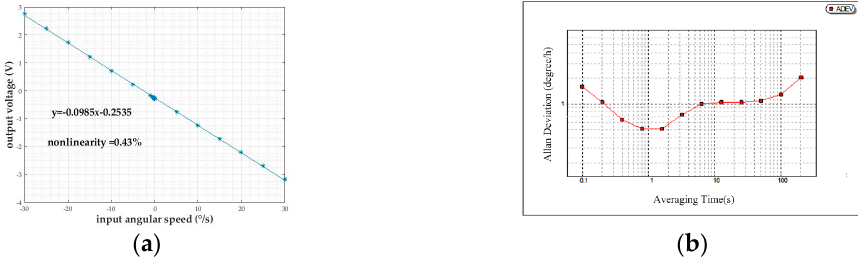
Figure 11. ( a ) linear fi tt ing of output voltages under input angular speed range of − 30°/s to 30°/s; ( b ) log-log plot of Allan deviation versus averaging time.